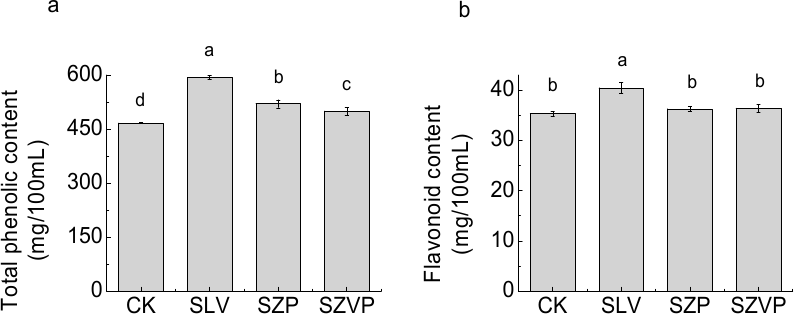
Figure 2. Contents of total phenols ( a ) and flavonoids ( b ) in raw juice and fermented goji juices. Different superscript letters (a–d) in the columns indicate significant difference ( p ≤ 0.05).